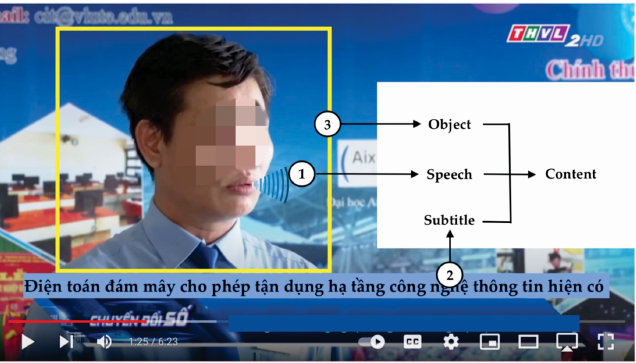
Figure 8. Video segmentation into objects, speeches, and subtitles.